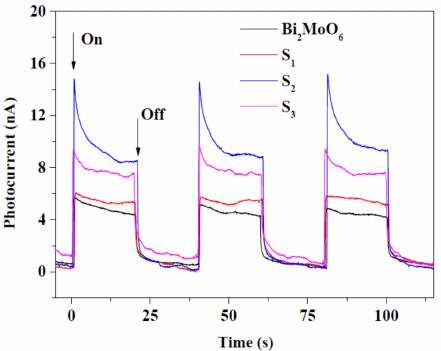
Figure 14. The photocurrent response of Bi 2 MoO 6 and the composite materials (S1–S3) (Reproduced with permission from Reference [165] published by Elsevier).